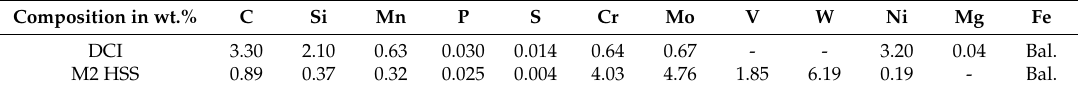
Table 1. Chemical composition of the two materials (wt. %).